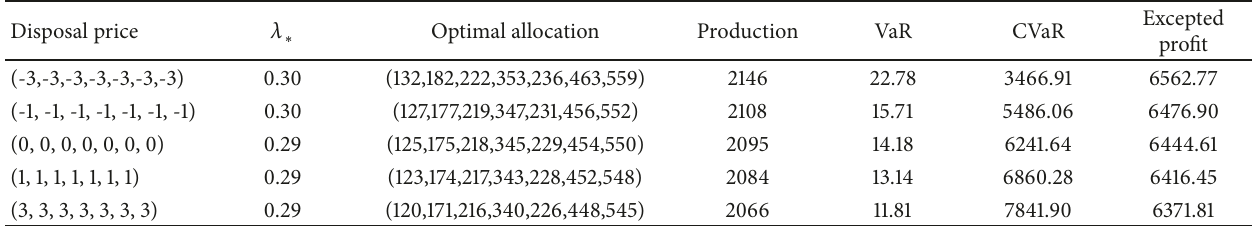
Table 4: A comparison of the above three. Decentralized allocation 𝜆 = 0 .